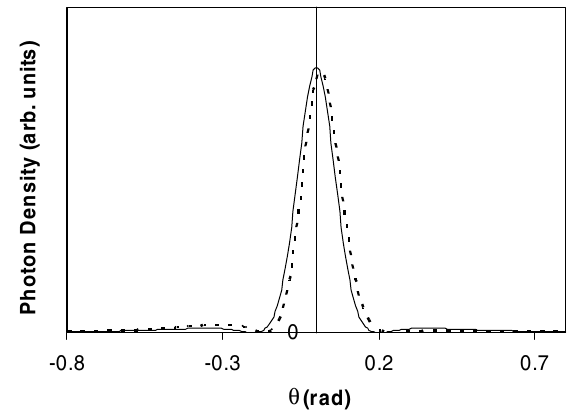
FIG. 5. Scattered energy density vs scattering angle ( (cid:24) ) from the z axis in the x - z plane (solid line) and the y - z plane (dotted line) for the case of a relativistic electron ( (cid:15) (cid:2) 2 ) traveling in along the z axis and an x polarized photon incident in the negative z